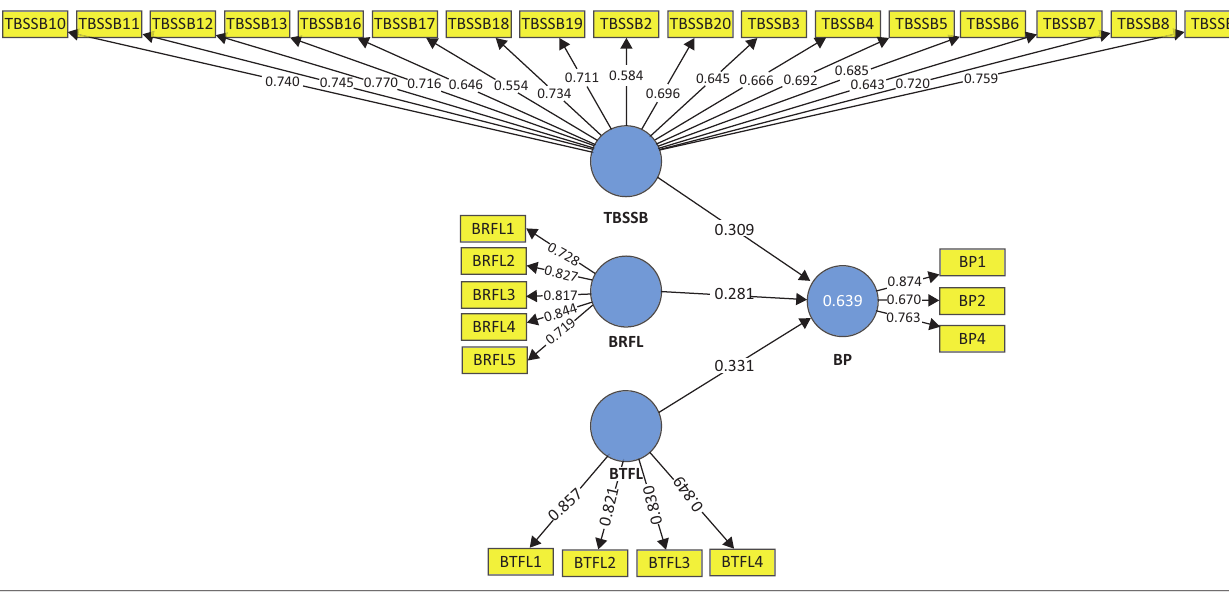
TBSSB, technology-based self-service banking; BRFL, borrowing financial literacy; BTFL, budgeting financial literacy; BP, business performance. FIGURE 2: Measurement and structural model results. TABLE 4: Results of structural equation model analysis. Path Hypothesis Path coefficients ( β